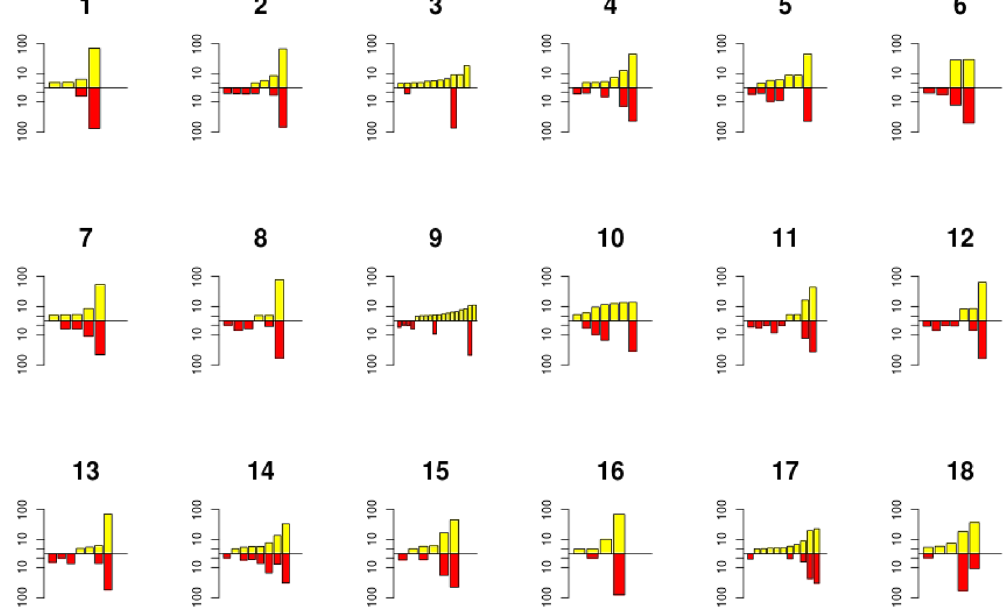
Figure 3. The number and variation of HCV haplotypes in 18 paired liver and plasma samples. The graphs indicate the number and frequency of each haplotype with a cut-off of a frequency of 1% or higher per haplotype, per liver (yellow) and plasma (red) sample of each patient (indicated by a number above the